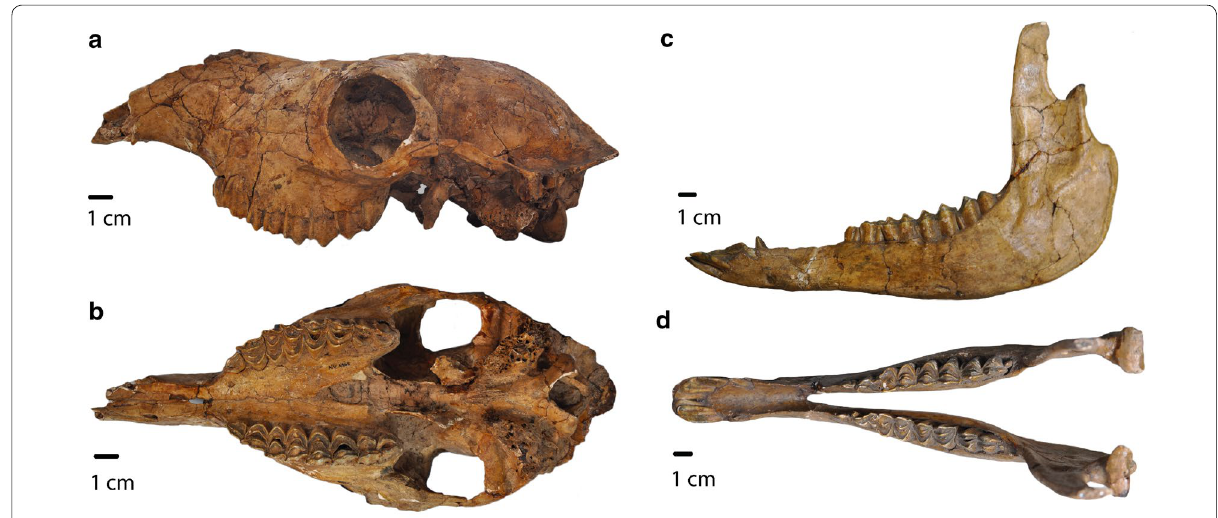
Fig. 10 PIMUZ A/V 4165. a Skull lateral view. b Skull occlusal view. c Mandible lateral view. d Mandible occlusal